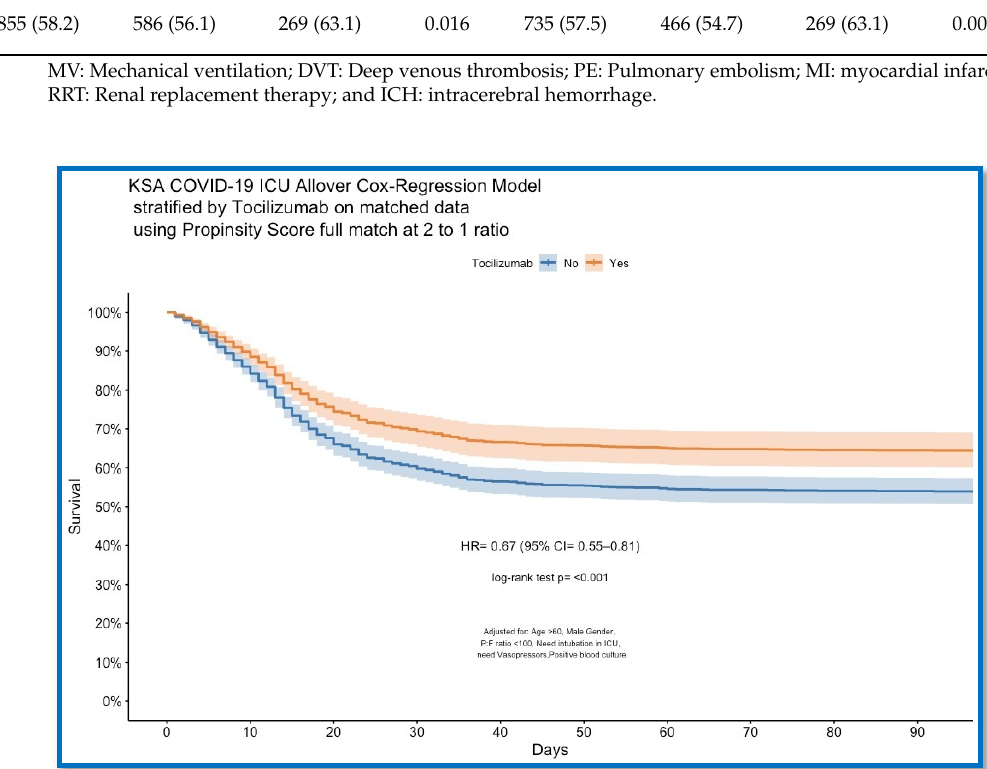
Table 3. Complications and patient outcomes.